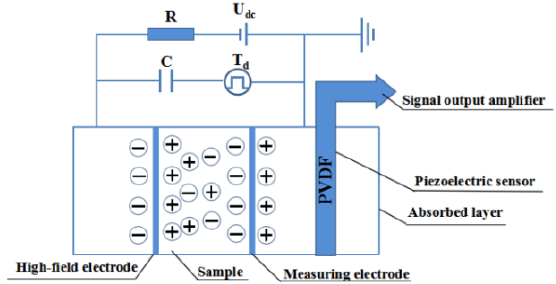
Figure 3. Schematic diagram of pulsed electro-acoustic method.